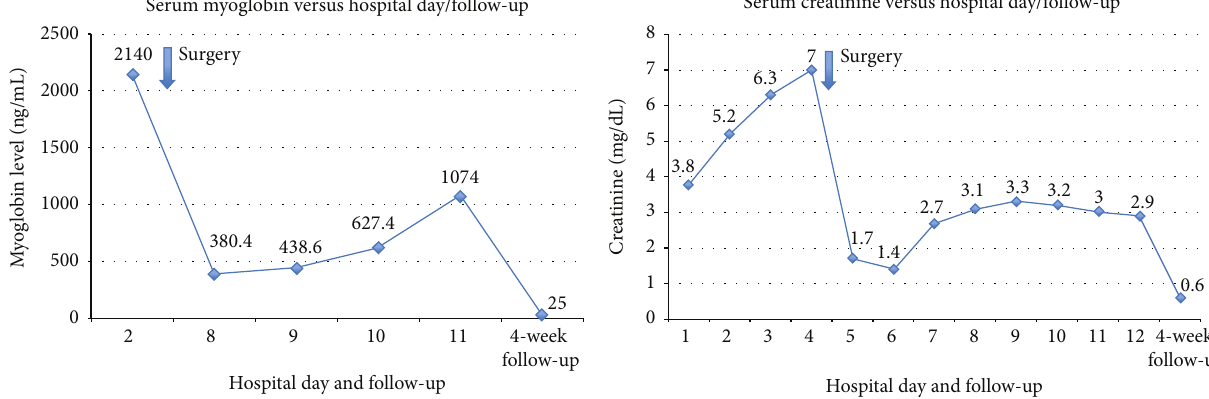
Figure 2: Serum myoglobin and creatinine levels during the patient’s hospitalization and on the 4-week follow-up.